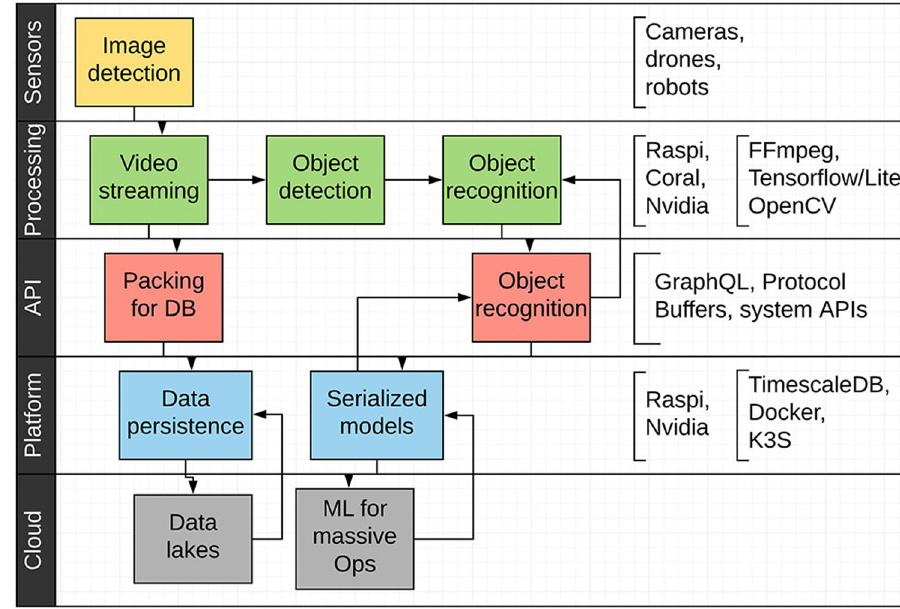
Figure 2: Image detection and respective ML process with participating devices and software